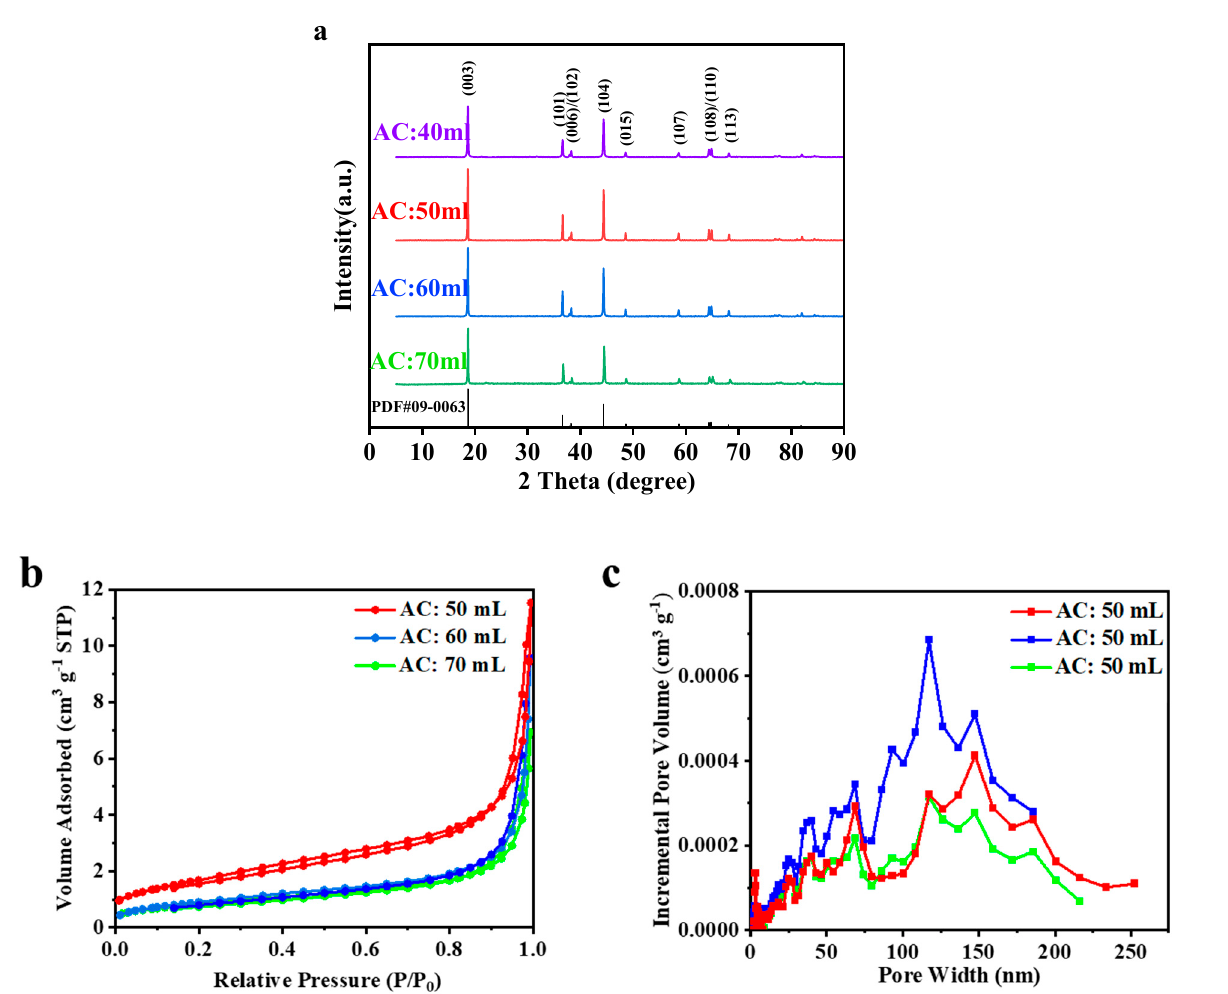
Figure 2. ( a ) XRD patterns of NCM622 different from ammonia content. ( b , c ) Nitrogen adsorption isotherm and Pore size distribution of NCM622 different ammonia content. Table 2. XRD parameters of NCM622 different ammonia content.